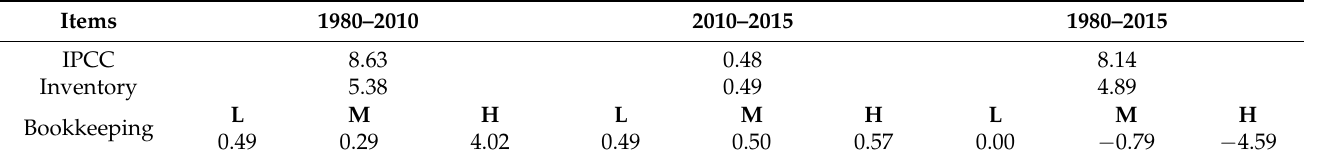
Table 4. Carbon stock change caused by land use type conversion from 1980 to 2015 in Henan Province (unit Tg